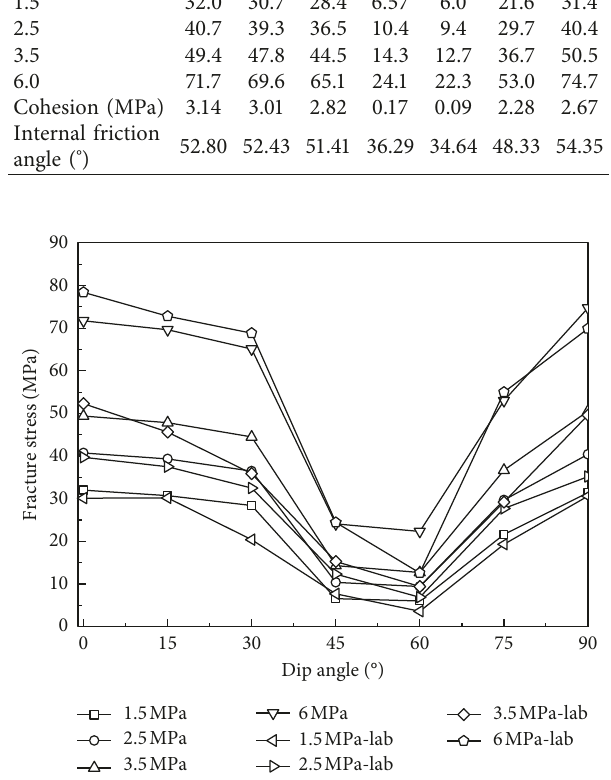
Figure 3: Numerical simulation and analogy experimental results of fracture stress of rockmass with different dip angles.